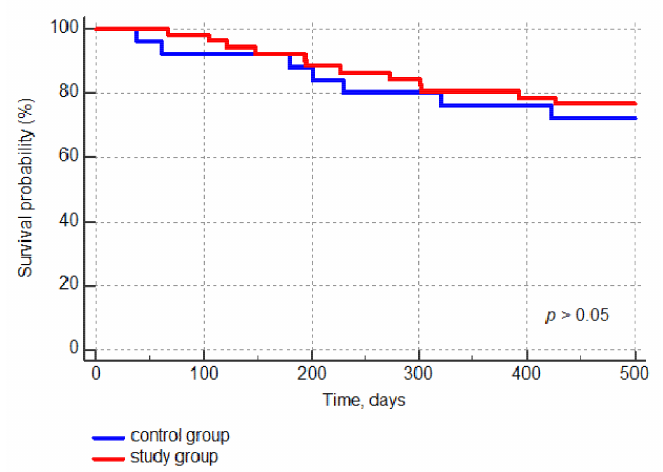
Figure 2. Comparison of the Kaplan–Meier curve for overall survival (OS) in the study group and the control group.